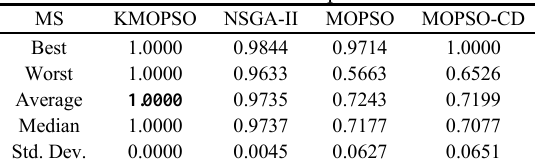
Table 22 . Results of the maximum spread metric for